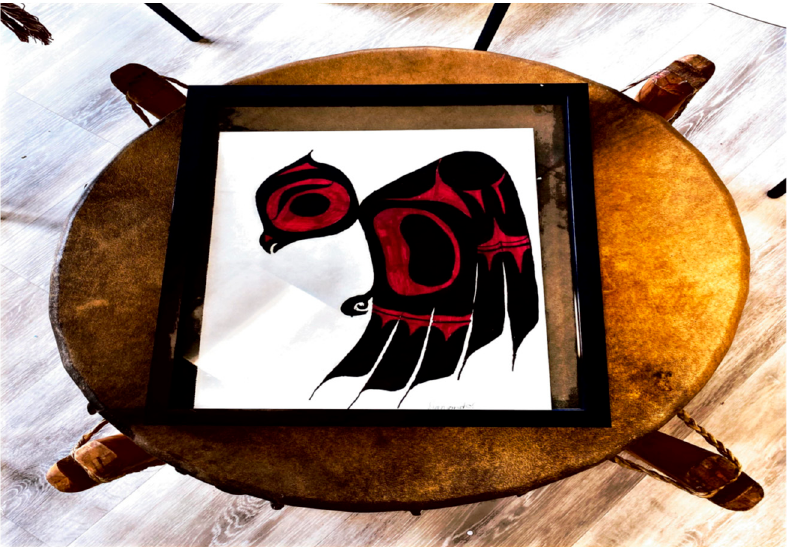
Figure 1. Sacred Medicine: Baby Owl on a Drum; The beginning story of self-reflection with the heartbeat of mother earth—Geralyn Dorothy Wright.